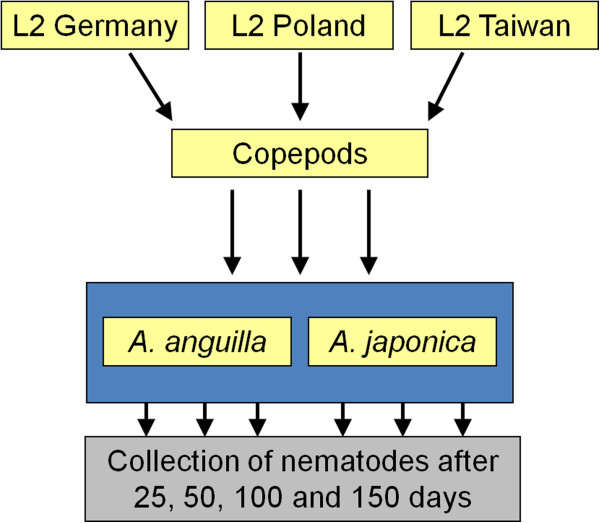
Experimental design.